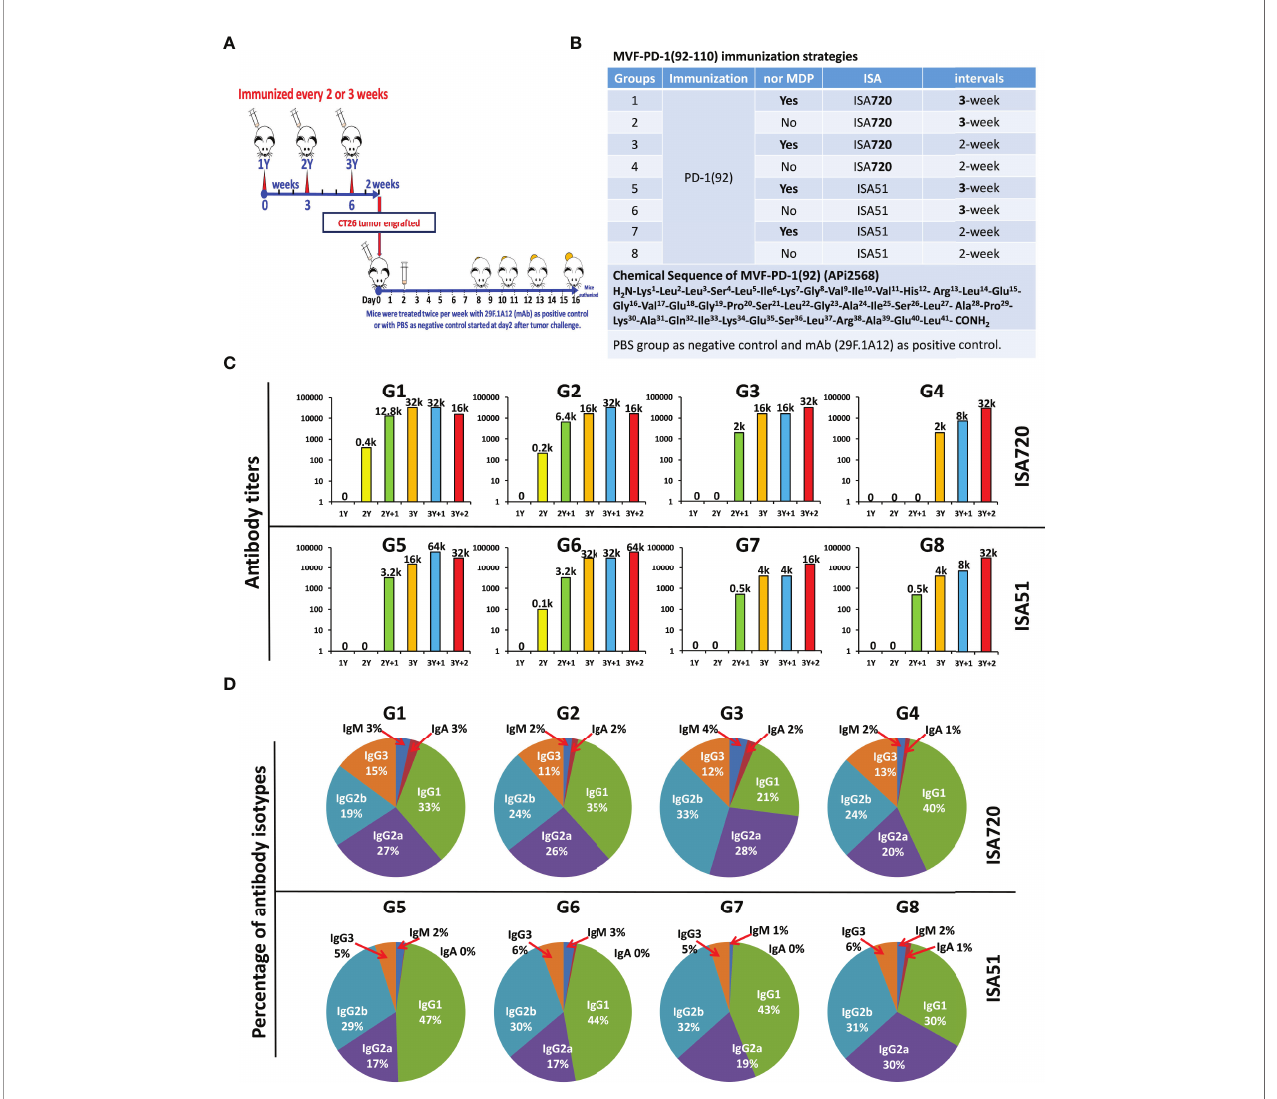
FIGURE 1 | Immunogenicity and antibody isotypes of CT26 BALB/c mice model. (A) Approximately 6 – 8 weeks old female BALB/c mice were vaccinated with MVF-PD-1(92-110) for every 2- or 3-week interval. Peptide cancer vaccine 100 m g mixed with ISA 720 (1:1) or ISA 51 (1:1) or nor-MDP 33 m g were used per mice. Mice were boosted with the designed doses for every 2- or 3-week intervals. Blood was collected weekly for monitoring antibody titers. After 2 weeks of the third-time immunization (3Y), mice were challenged with CT26 colon carcinoma cells for 1 × 10 5 cells per mice. The tumor growth was checked daily, especially 7 days of post-challenging, and the tumor size was measured with a caliper. For the positive control group, we treated the mice with anti-mouse PD-1 antibody (clone 29F.1A12) twice a week for up to three weeks, in which the negative control group was treated with PBS. (B) Mice CT26 tumor model study was separated into 10 different groups, post-challenge treated with PBS or anti-mouse PD-1 antibody (clone 29F.1A12) are negative control group and positive control group, respectively. From group 1 to group 8 are the peptide vaccine treatment groups. Groups 1/2/5/6 were treated every three weeks, while groups 3/4/7/8 were treated every 2 weeks. ISA 720 was used in group 1/2/3/4, while ISA 51 was used in group 5/6/7/8. Nor MDP was involved in group1/3/ 5/7. (C) Immunogenicity of MVF-PD-1(92-110) peptides immunized BALB/c mice. Mice bleeds were collected weekly except the fi rst collection was 3 weeks after primary immunization, and ELISA were used to detect antibody titers in sera; the highest dilution refer to the antibody titers as indicated in the images, for example, 12.8k indicates 1 to 12.8k or 1 to 12,800 dilution; (D) Antibody isotypes of BALB/c mice after immunized with MVF-PD-1(92-110) in each group. Each subtype of antibody was calculated as percentage indicated in the images. Group 1 has been published on Oncoimmunology 2020, VOL. 9, NO. 1,